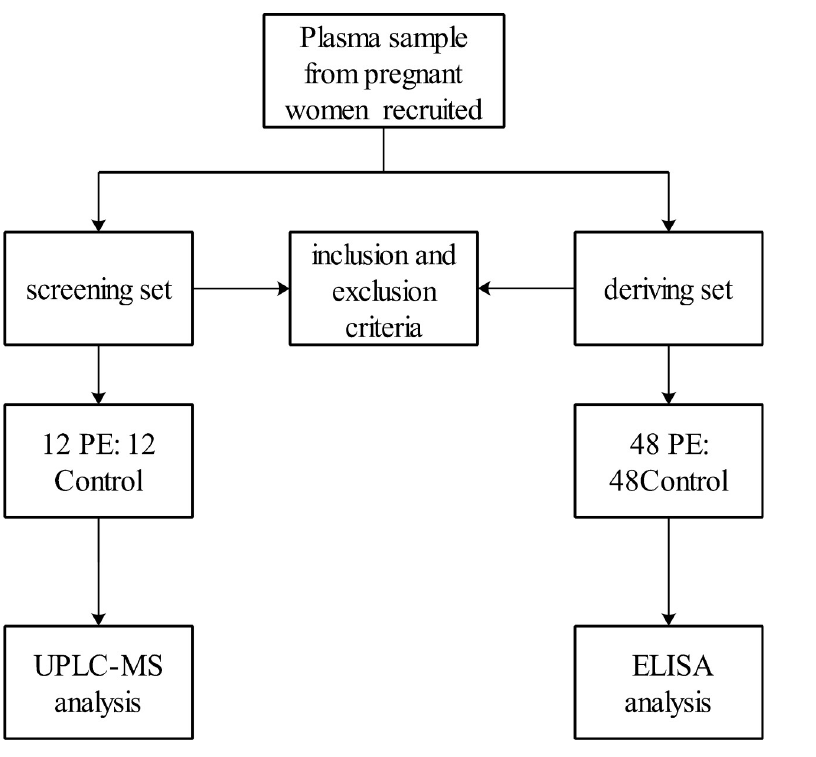
Fig 1. Flow diagram of the participants in the plasma study.